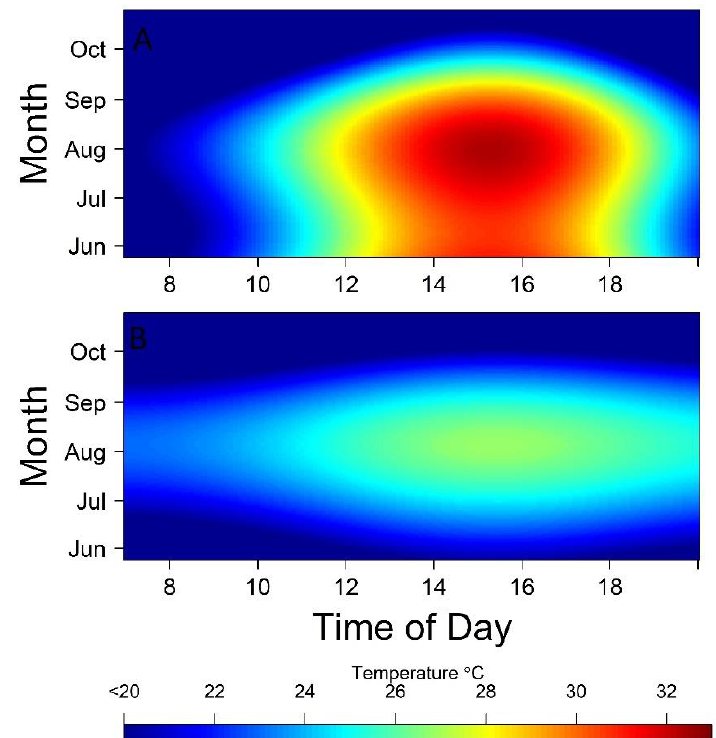
Figure 3. Heat map showing estimated mean temperature of isolated pools ( A ) or areas with perennial flow ( B ) from June through October, 2011 to 2016 in the Middle Rio Grande, New Mexico, by time of day and date, with cooler temperatures shown in blue.